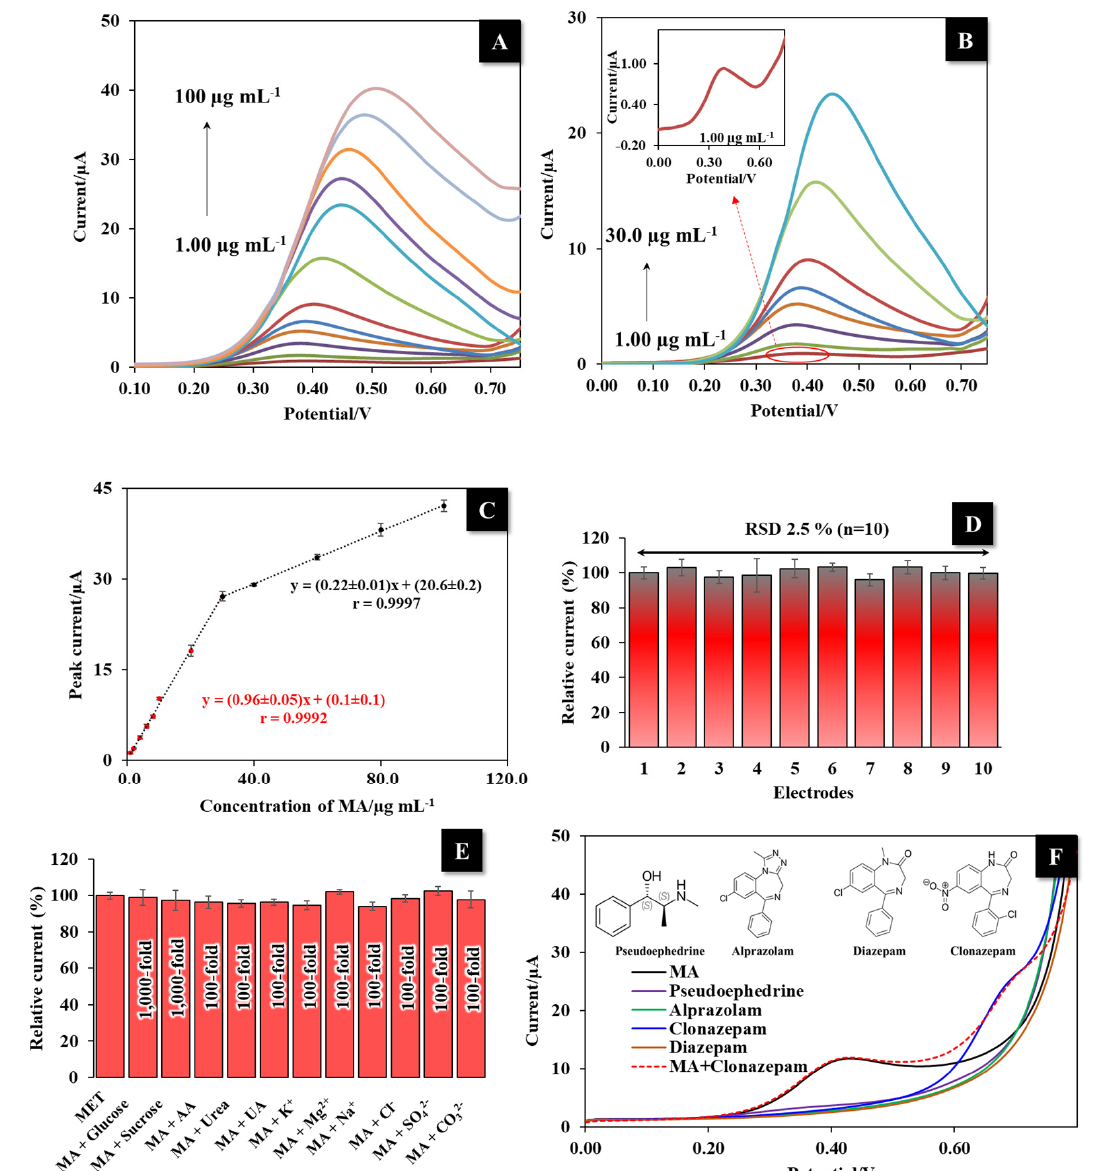
Figure 6. ( A ) DPV responses of MA (1.00 to 100 µ g mL − 1 ) at the LI-PGr electrode coupled with the developed portable device. ( B ) DPV responses of MA (1.00 to 30 µ g mL − 1 ) at the LI-PGr electrode; inset—amplified anodic peak current of MA at a concentration of 1.00 µ g mL − 1 . ( C ) Calibration curve of current signal of MA versus its concentration (1.00–100 µ g mL − 1 ). ( D ) The relative current responses from ten LI-PGr electrode preparations. ( E ) Anti-interference ability of the developed sensor. ( F ) DPV responses of MA (10.0 µ g mL − 1 ), pseudoephedrine (10.0 µ g mL − 1 ), alprazolam (10.0 µ g mL − 1 ), clonazepam (10.0 µ g mL − 1 ), diazepam (10.0 µ g mL − 1 ), and a mixed solution of MA (10.0 µ g mL − 1 ) and clonazepam (10.0 µ g mL − 1